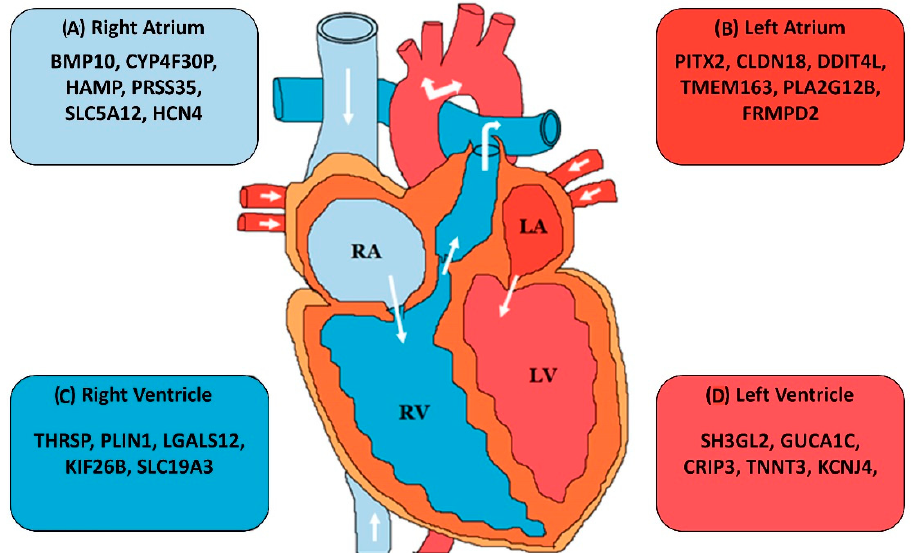
Figure 2. Chamber specific gene expression in human heart: the figure provides an overview of the genes which have been found to be enriched in the ( A ) right atrium, ( B ) left atrium, ( C ) right ventricle, and ( D ) left ventricle as compared to other heart chambers [150–153].